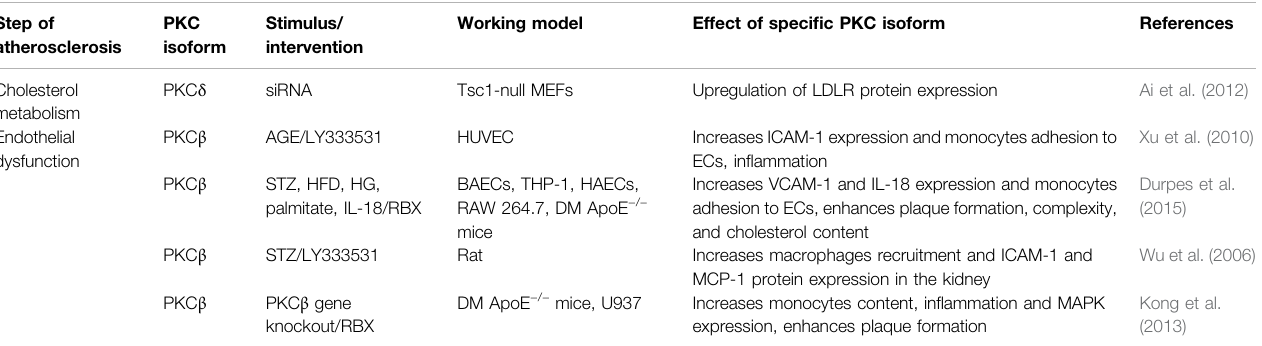
TABLE 2 | Summary of PKC isoform-speci fi c role in diabetes-associated atherosclerosis. Step of